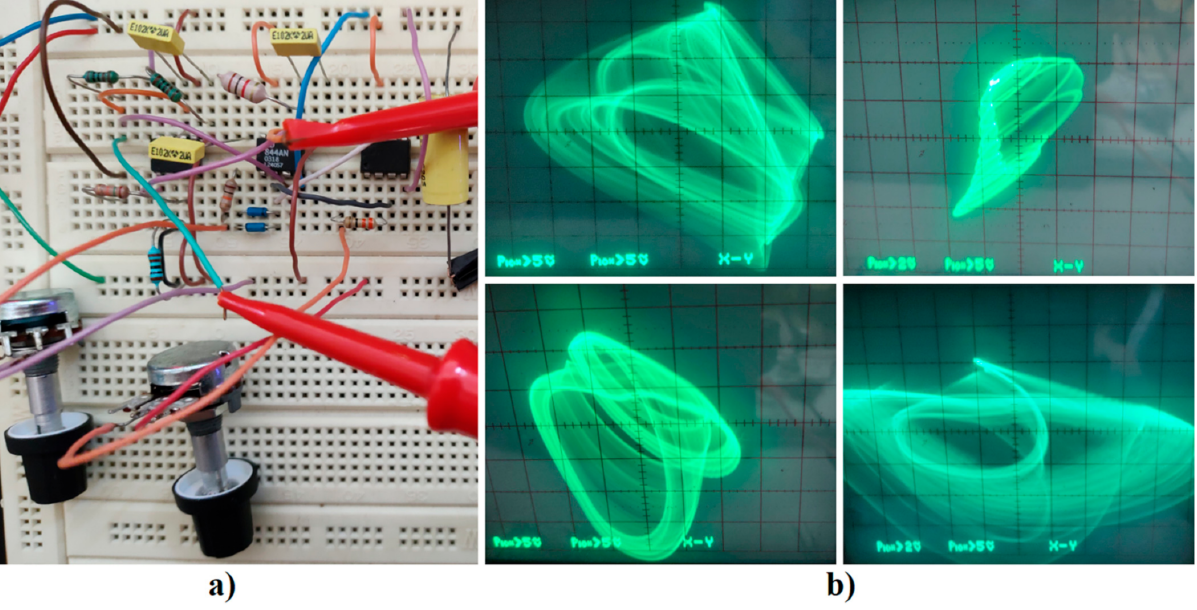
Figure 11. Chaotic attractors associated with Clapp oscillator, Case II, real measurement: ( a ) bread- board realization and ( b ) selected plane projections captured as oscilloscope